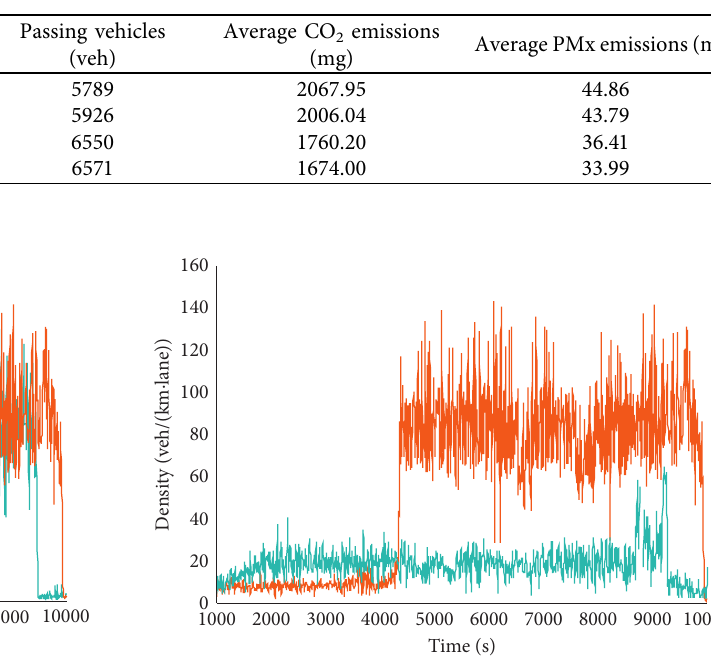
Table 8: Simulation result.